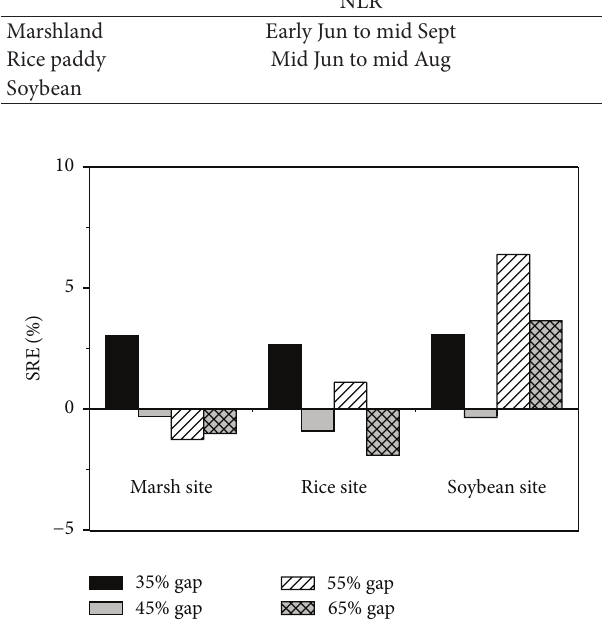
Figure 7: The sum relative error (SRE) of optimum gap-filling method for four-gap level at three